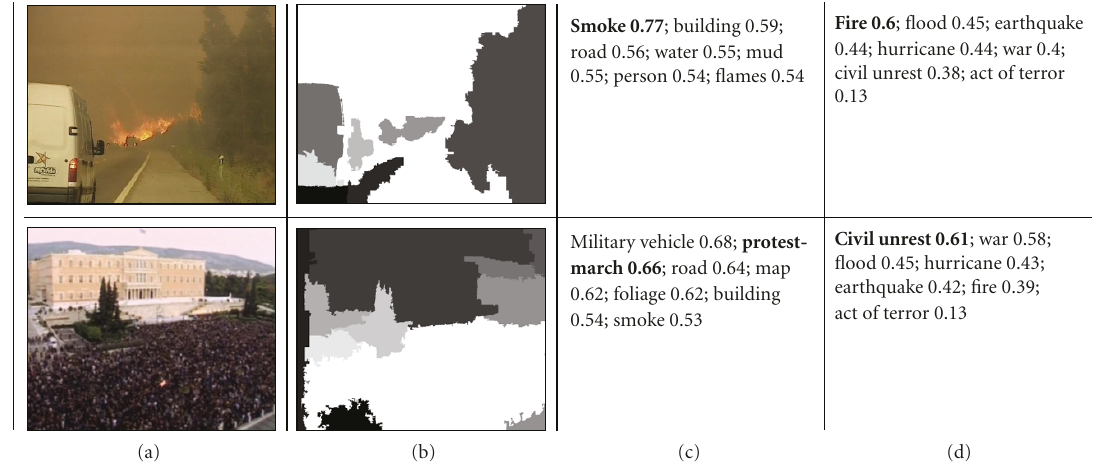
Figure 4: Visual classification examples: (a) keyframe, (b) segmentation mask, (c) results of region classification for the spatial region shown in white in the mask (only a few region-level concepts, in descending order according to the estimated degree of confidence, are shown) and (d) final keyframe classification results (in descending order according to the estimated degree of confidence), generated by combining the region-level classification results for all regions and the results of global classifiers. The concepts that are in agreement with the ground truth annotation are shown in bold. Taking into account all region-level classification results rather than the single highest-ranking region- level concept for every region, when estimating the final keyframe classification results, is motivated by the known imperfection of region classifiers (as seen in the second